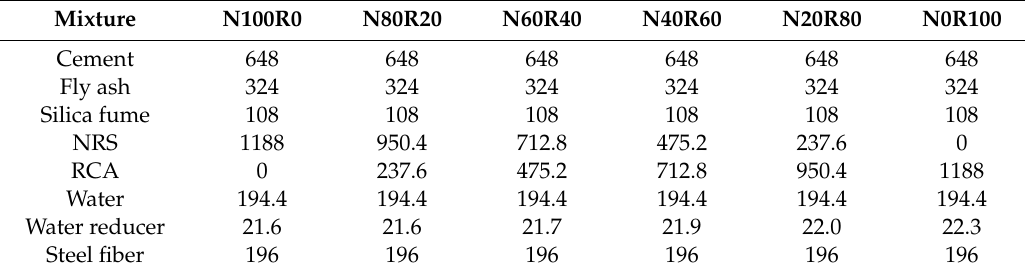
Table 2. Mix proportions of UHPC (kg / m 3